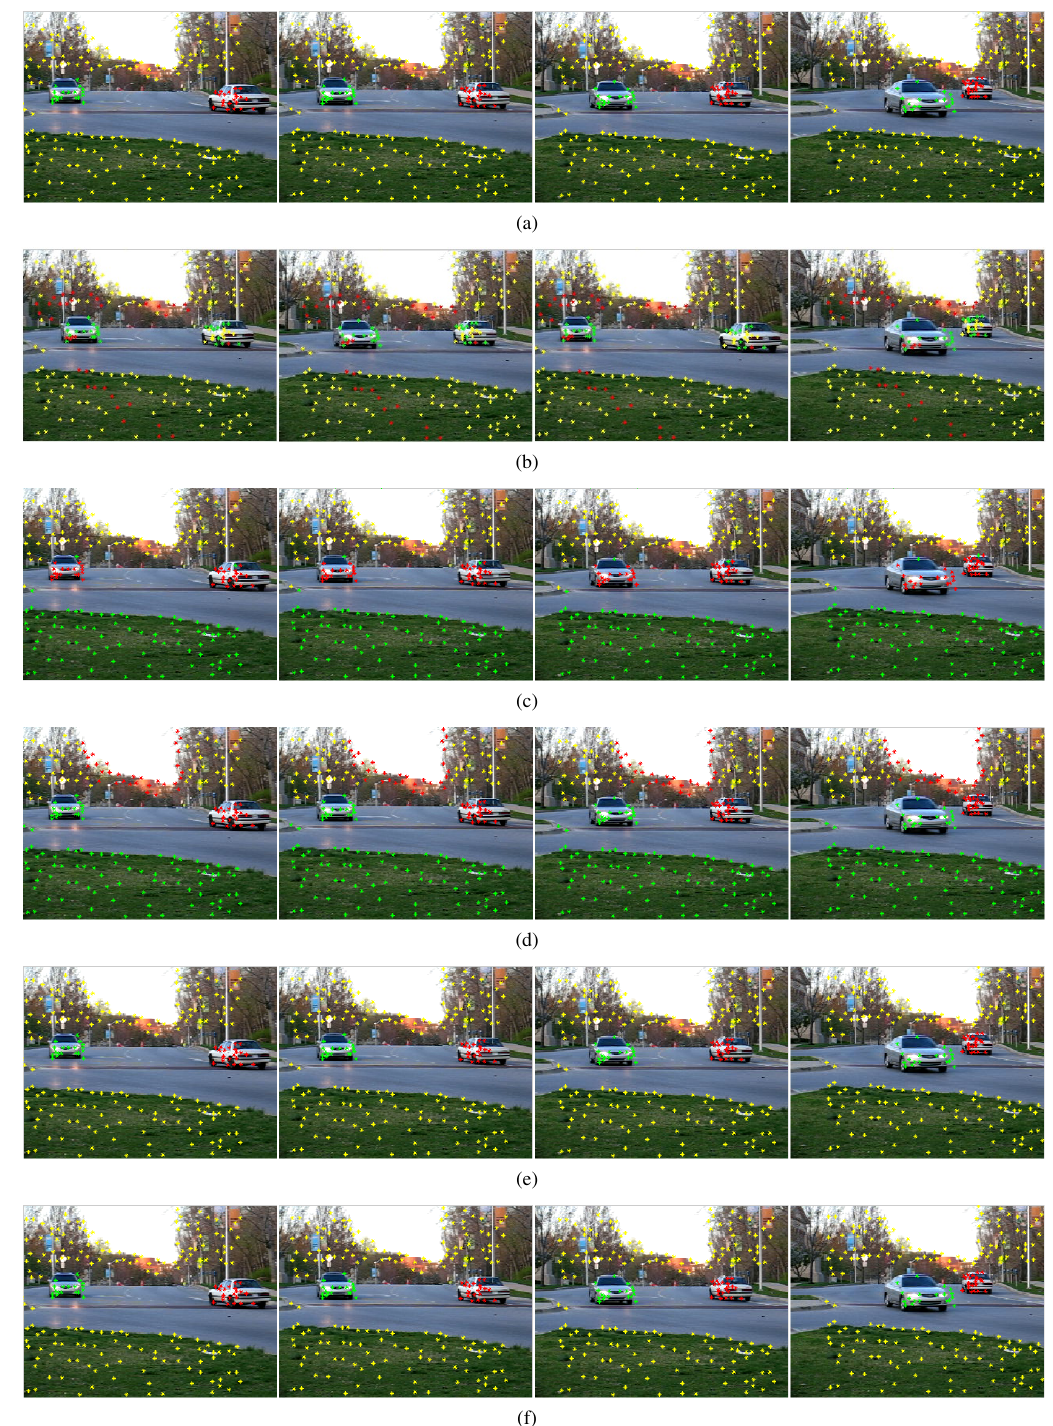
Figure 6: Comparison of Our approach with ground truth and the other approaches on the 1RT2RC video: 6(a): GroudTruth; 6(b): GPCA, error: 19 . 34% ; 6(c): LSA, error: 46 . 23% ; 6(d) MSMC, error: 46 . 23% ; 6(e) SSC, 0% ; 6(f): Our, 0%